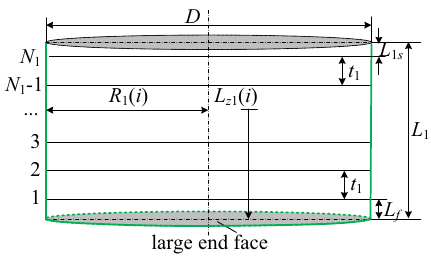
Figure 3. The design sketch of the cylindrical